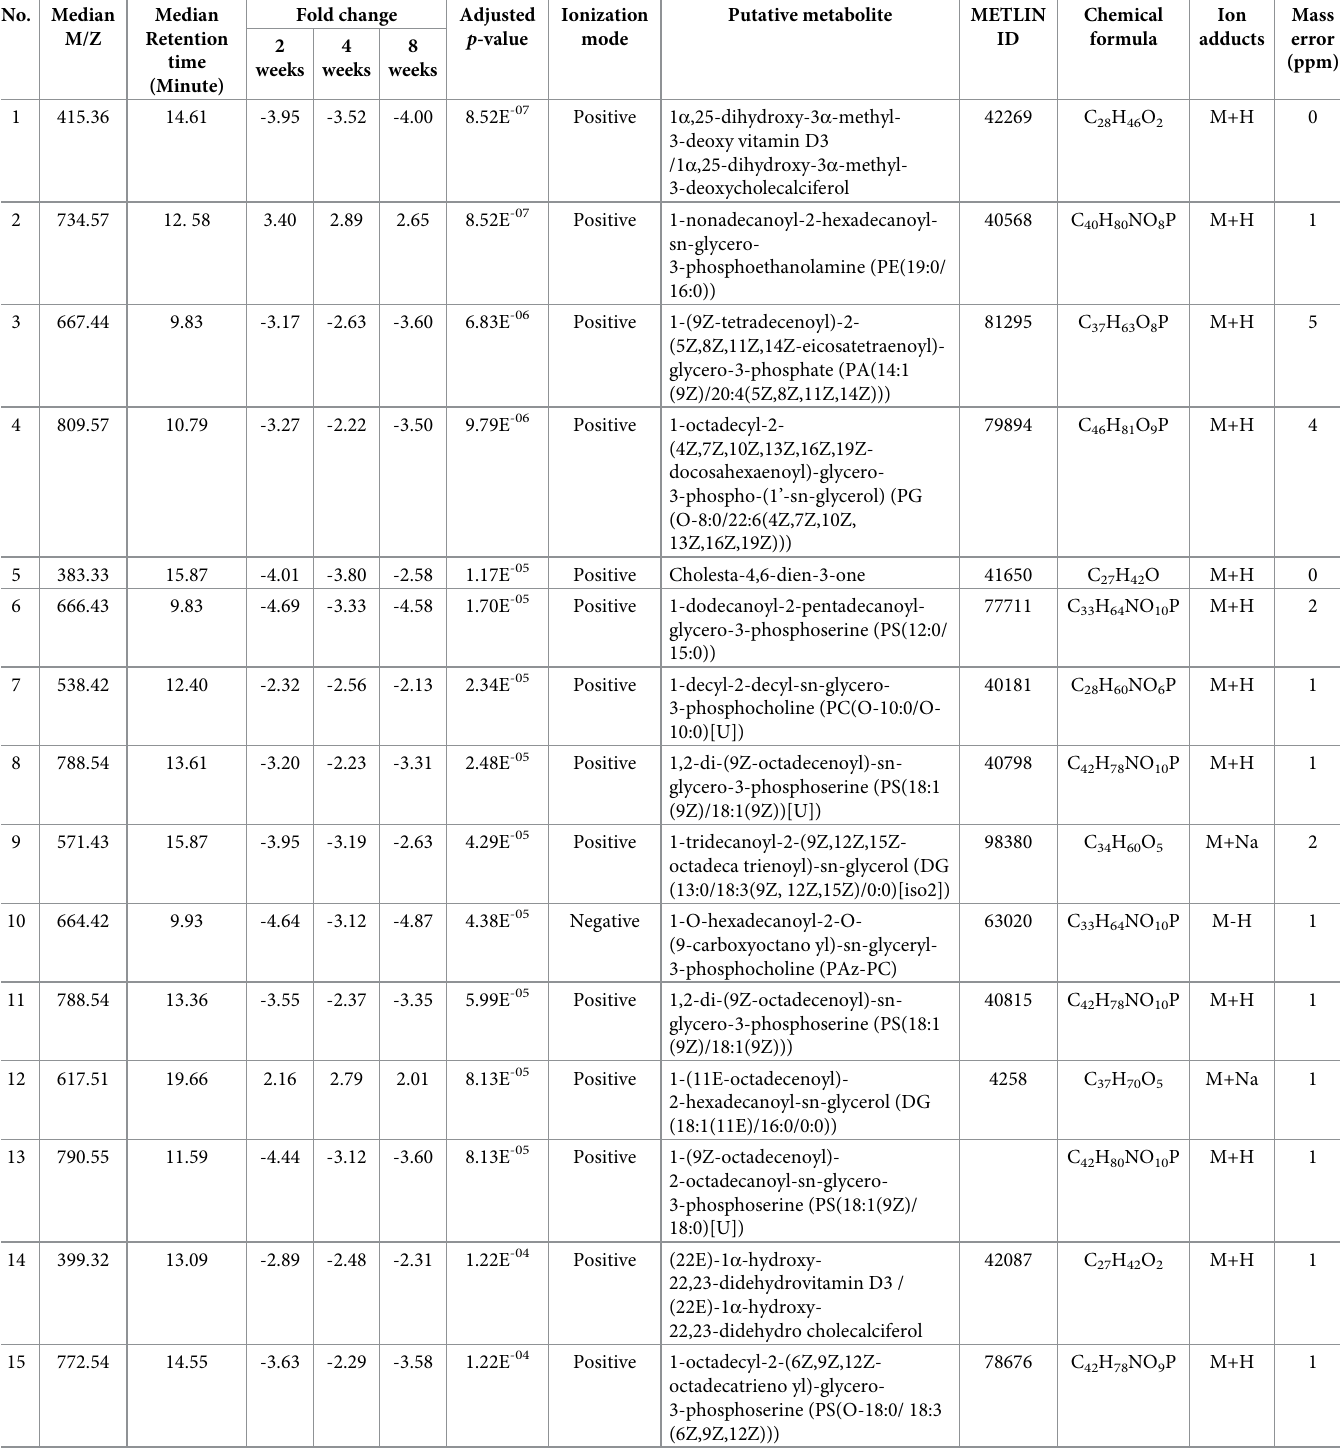
Table 2. Top 15 putative metabolites from all time-points after T . spiralis infection (ranked by adjusted p- value those had fold change ± 2.0). No. Median